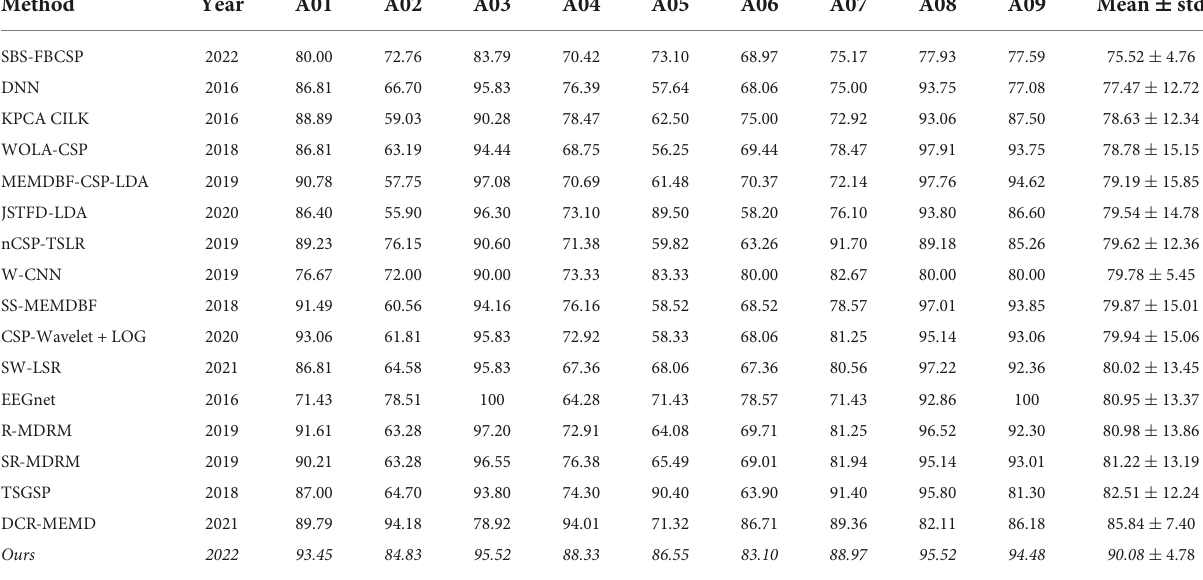
TABLE 1 Performance comparison for dataset 1, sorted by accuracy.